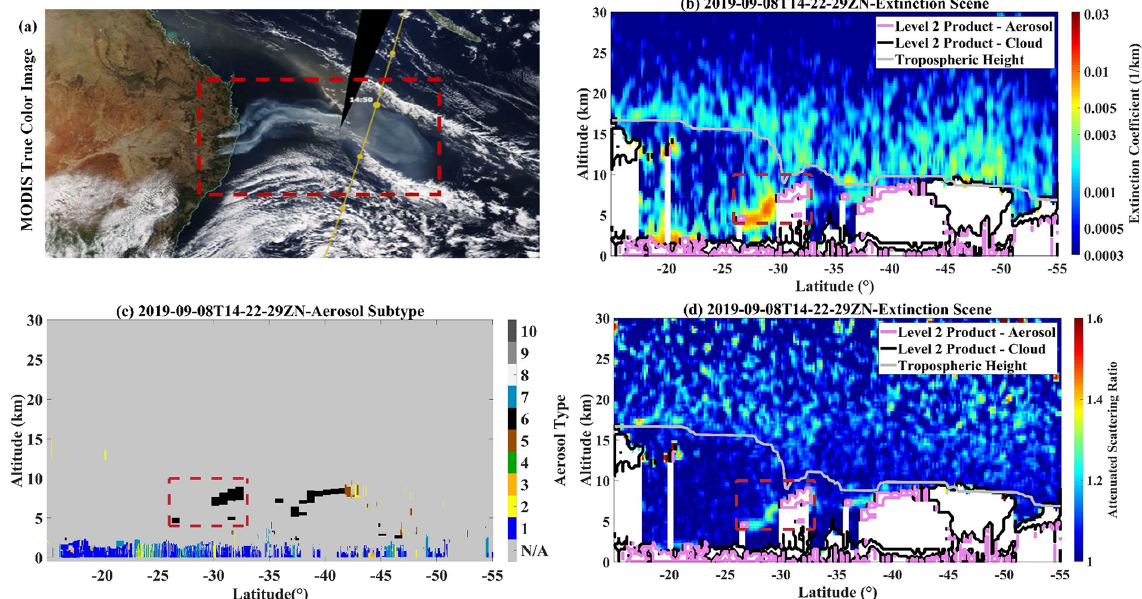
Figure 7. (a) MODIS Terra true-colour image at daytime and the passing CALIPSO track (yellow line) at night-time. (b) Latitude–altitude of undetected aerosol extinction of the corresponding night-time CALIPSO track, which is consistent with Fig. 4a. The purple and black boundary lines and extinction inside represent the detected aerosol and cloud layers provided by CALIPSO level 2 products, respectively. (c) Aerosol subtypes in CALIPSO VFM product (N/A stands for not applicable, 1 is marine, 2 is dust, 3 is polluted continental/smoke, 4 is clean continental, 5 is polluted dust, 6 is elevated smoke, 7 is dusty marine, 8 is polar stratospheric aerosol, 9 is volcanic ash, and 10 is sulfate/other). (d) Attenuated scattering